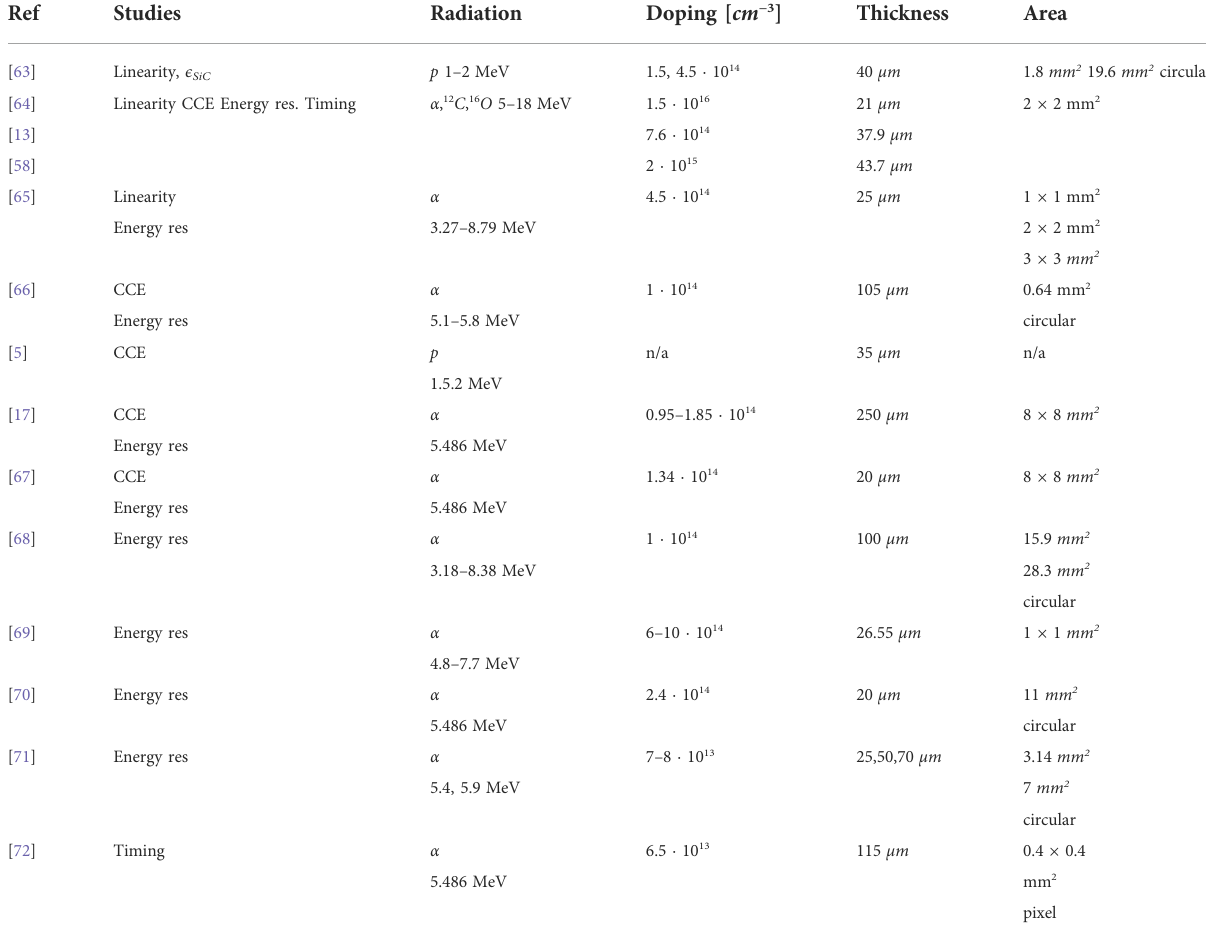
TABLE 2 The main detector properties, the type of radiation used, and the detector characteristics studied in the works cited in Par.